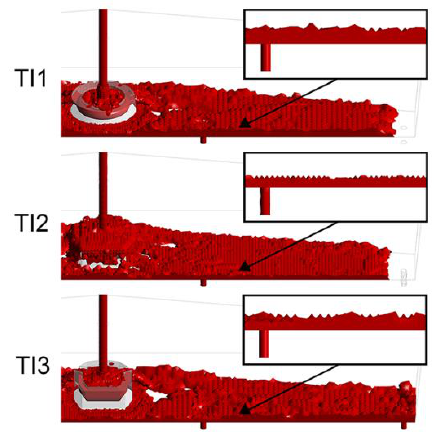
Figure 4. Initial liquid streams at startup conditions for each TI.